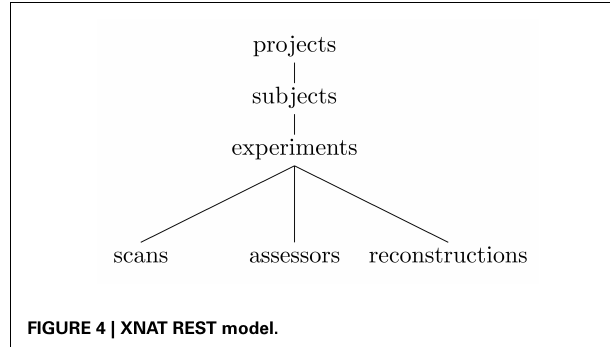
FIGURE 4 | XNAT REST model.